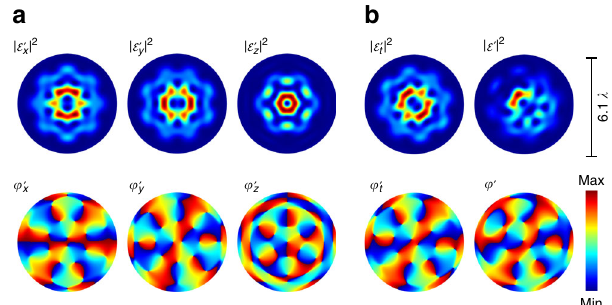
Fig. 3 SAM fl uorescence excited by non-paraxial light. Analysis for d ( x , y ) = c [1, 1, 1] T , ∀ ( x , y ) and fl uorescence caused by non-paraxial light fi elds with signi fi cant E z contributions shown by the example of a focused fl ower structure ( σ 12 = 8) with additional phase vortex ‘ ¼ 2. a Normalized intensity jE 0 x ; y ; z j 2 ð2 ½ 0 ; 1 (cid:2)Þ and relative phase φ 0 x ; y ; z ð2 ½ 0 ; 2 π (cid:2)Þ contributions emitted by monolayer, excited by E x ; y ; z . b Normalized intensities jE 0 t j 2 and j E 0 j 2 ð2 ½ 0 ; 1 (cid:2)Þ with relative phases φ 0 t and φ 0ð2 ½ 0 ; 2 Π (cid:2)Þ corresponding to E 0 t ¼ E 0 x þ E 0 y and E 0 ¼ E 0 0 0 x þ E y þ E z ,